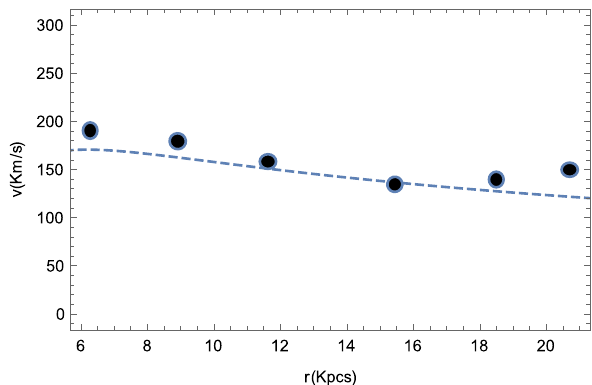
Fig. 1 Theoretical galactic f ( R ) rotation curve external to the typical visible end of galaxy NGC 5533. The black dots represent the observed data points due to HI [52–54]. The curve shows the behaviour of test massbeyondtheopticalradiusfor δ ≈ O ( 10 − 6 ) withthegalacticlength scale free parameter r 0 = 10 2 . 650 ≈ 446 . 6 kpc